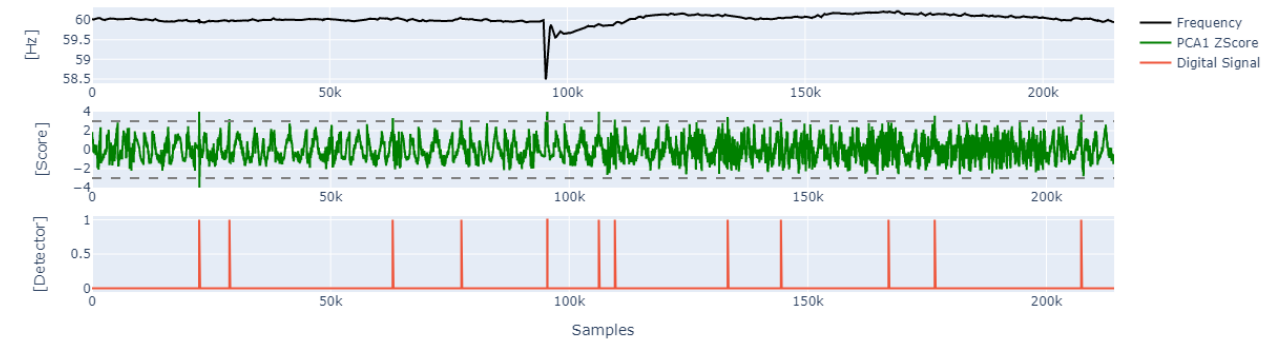
Figure 10. Event 1: detector event of PMU Bateias (located at Parana State).